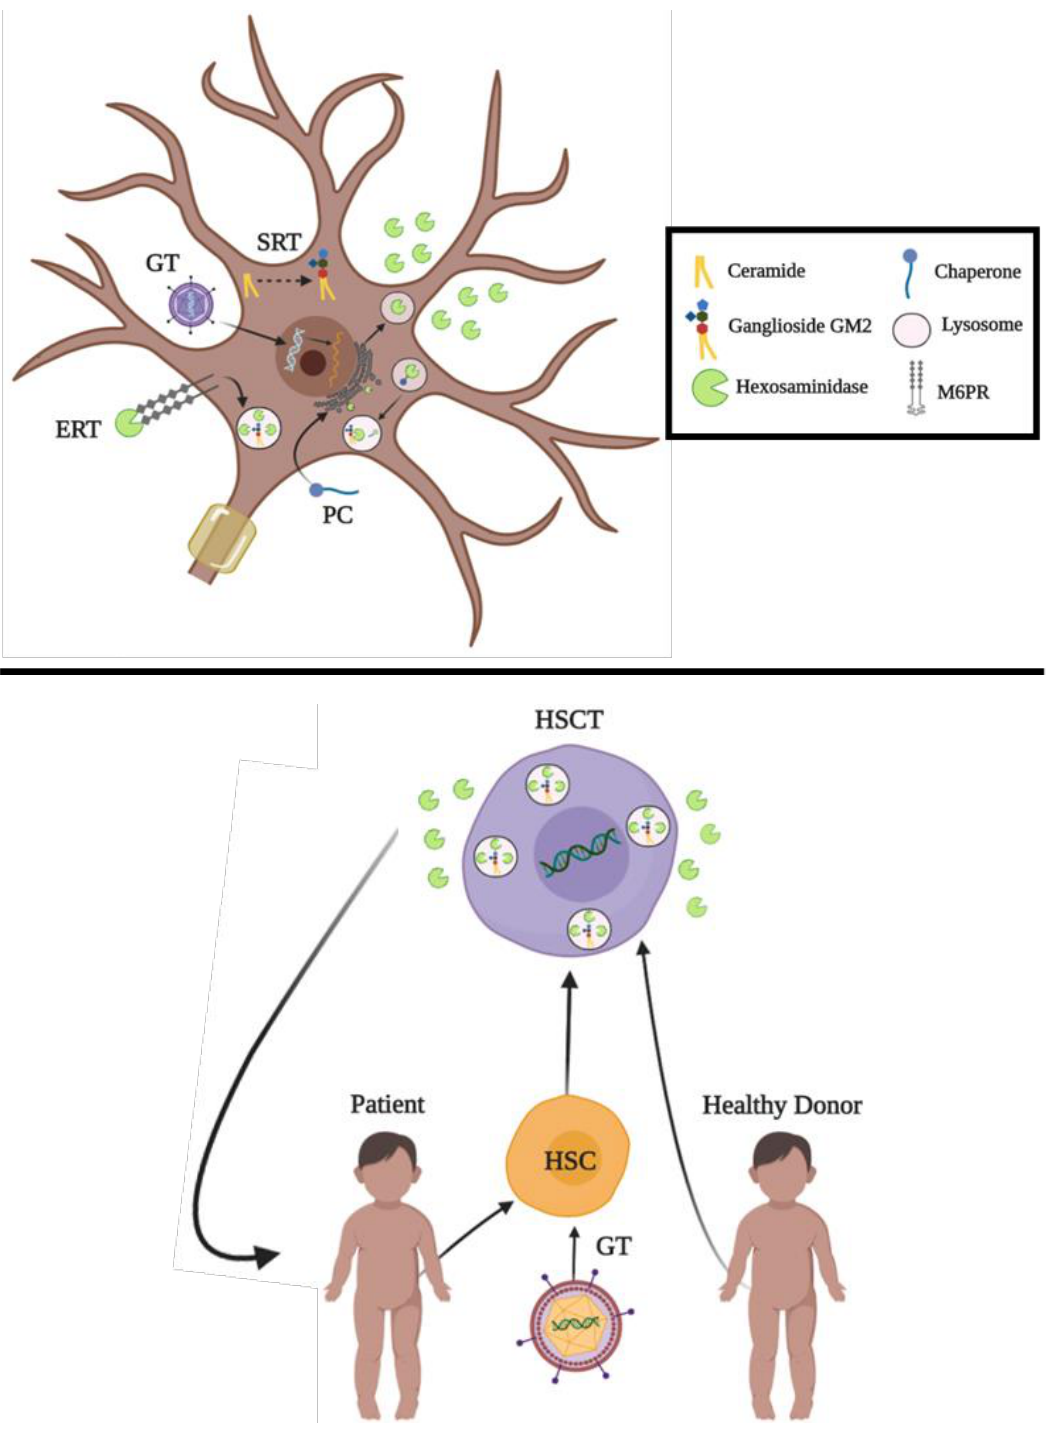
Figure 5. Therapeutic alternatives for GM2 gangliosidoses . The figure shows current proposals for in vivo ( upper ) and ex vivo ( lower ) approaches. Extracellular Hex represents exocytosis of the enzyme upon its translation, which supports the cross-correction hypothesis. GT: Gene Therapy. SRT: Substrate Reduction Therapy. PC: Pharmacological Chaperones. ERT: Enzyme Replacement Therapy. HSCT: Hematopoietic Stem Cell Transplantation. HSC: Hematopoietic Stem Cell.